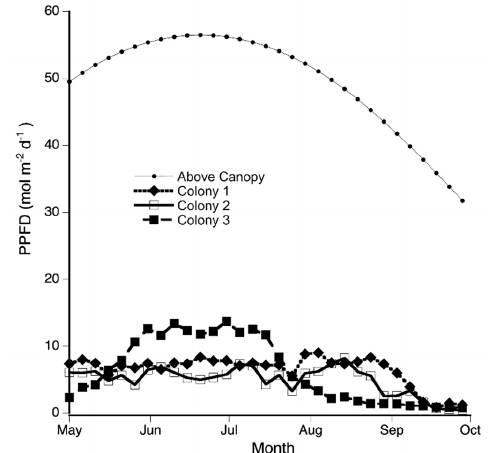
Figure 2. Colony 3 received more light than colony 1 and 2. From late May to the middle of July, Plagiochila porelloides colony C3 was estimated to receive more light than the two other P. porelloides colonies (PPFD below 9 mol m − 2 d − 1 ). Otherwise, colony C3 received similar or lower PPFD than the other two colonies. PPFD was estimated every 5 days from May to September using